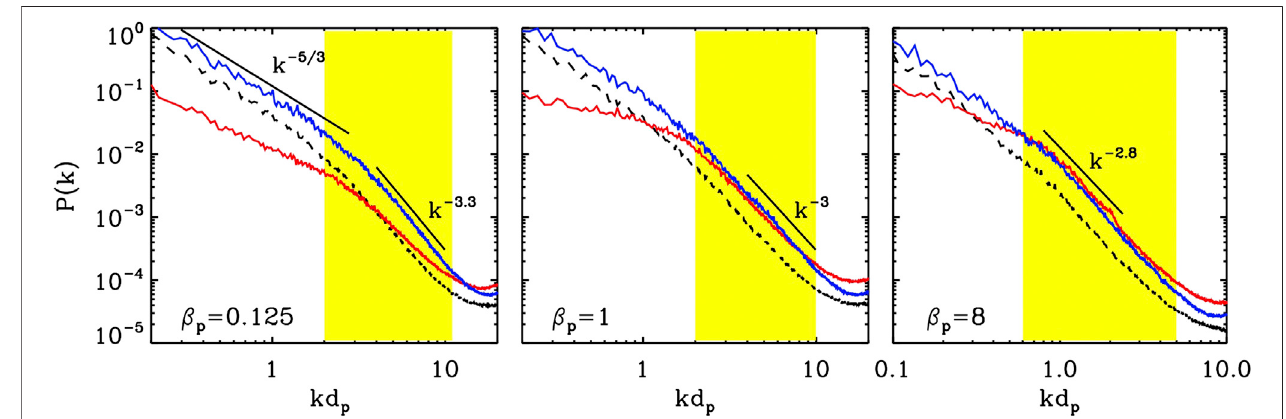
FIGURE 2 | Magnetic fi eld spectra from hybrid simulations for different beta regimes ( β p (cid:2) 0 . 125 , 1 , 10 and β e (cid:2) β p ). Components are encoded as in Figure 1 and the colored region indicates the sub-ion range that can be directly compared with the analogous region in the observations.